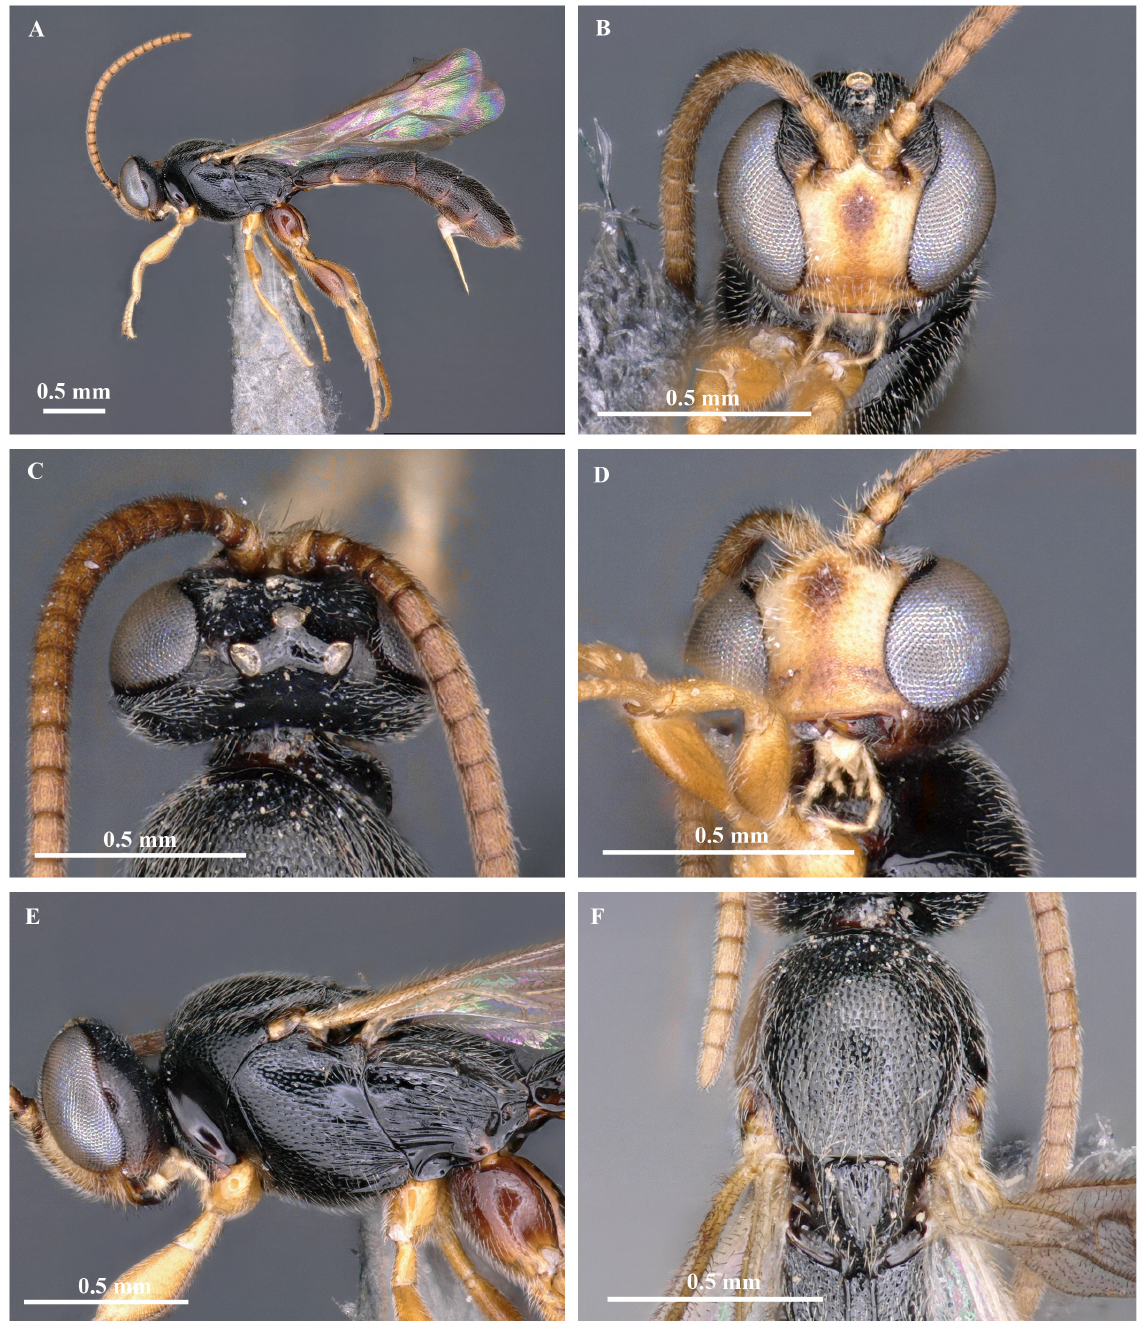
Fig. 3. Trieces isolatus sp. nov., holotype, ♀ (AIMB). A . Habitus, lateral view. B . Head, anterior view. C . Head, dorsal view. D . Head, latero-ventral view. E . Head and mesosoma, lateral view. F . Mesosoma, dorsal